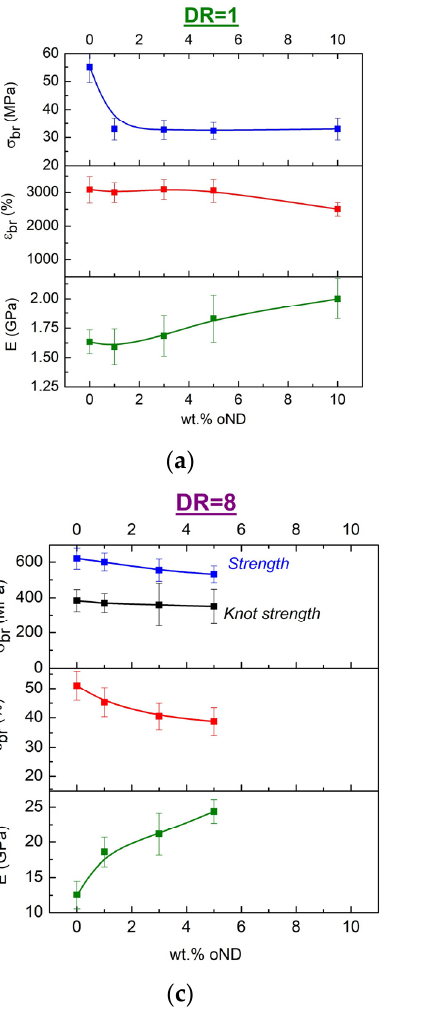
Figure 6. The mechanical characteristics of the composite fibers and dependences on the type and content of the nanofiller: ( a , b ) unoriented and ( c , d ) oriented